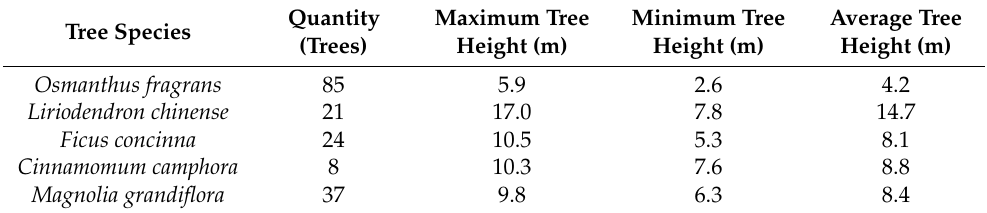
Table 1. The specific statistical results of the field survey data.